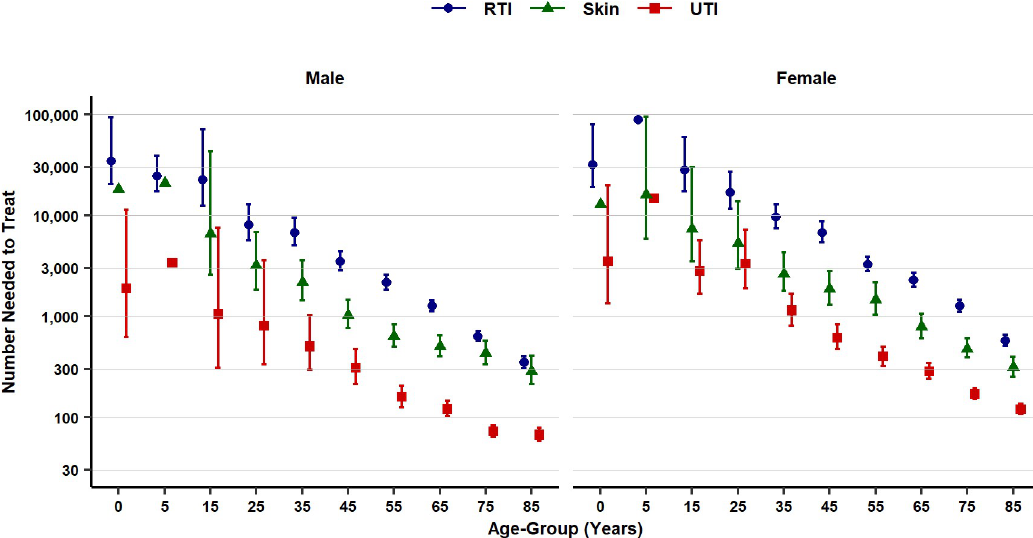
Fig 4. Number of antibiotic prescriptions required to prevent one sepsis event (NNT) by age group, gender, and type of infection consultation. Figures are median estimates (95% uncertainty interval). Uncertainty intervals were omitted for 0–4 years and 5–9 years if data were too sparse to give reliable estimates. NNT, number needed to treat; RTI, respiratory tract infection; UTI, urinary tract